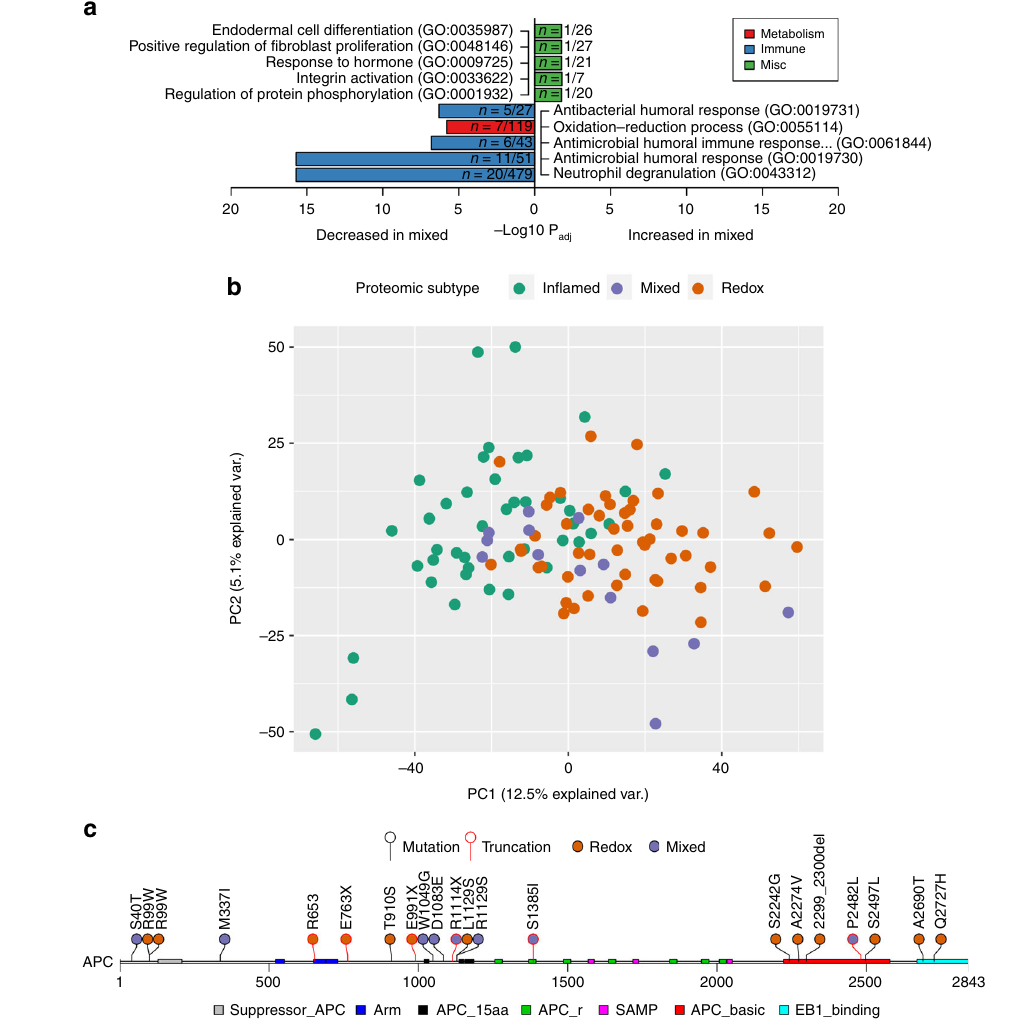
Fig. 6 The Mixed subtype has biology associated with Wnt/stromal signaling. a Pathway enrichment of signi fi cantly different proteins (±1.5 fold-change and P adj <0.05 compared to the rest of the cohort). There were no signi fi cantly elevated pathways in Mixed, but several pathways were decreased including immune and oxidation-reduction pathways. b Principal component analysis of the three subtypes reveal distinct clustering of In fl amed to the left, Redox on the right, and Mixed interspersed throughout. c Lollipop plot of APC alterations in the cohort with PFAM domain annotation (https://pfam.xfam.org/) extracted from cBioPortal (http://www.cbioportal.org). Mutations with black lines were nonsynonymous and red lines were truncating. In fl amed had no